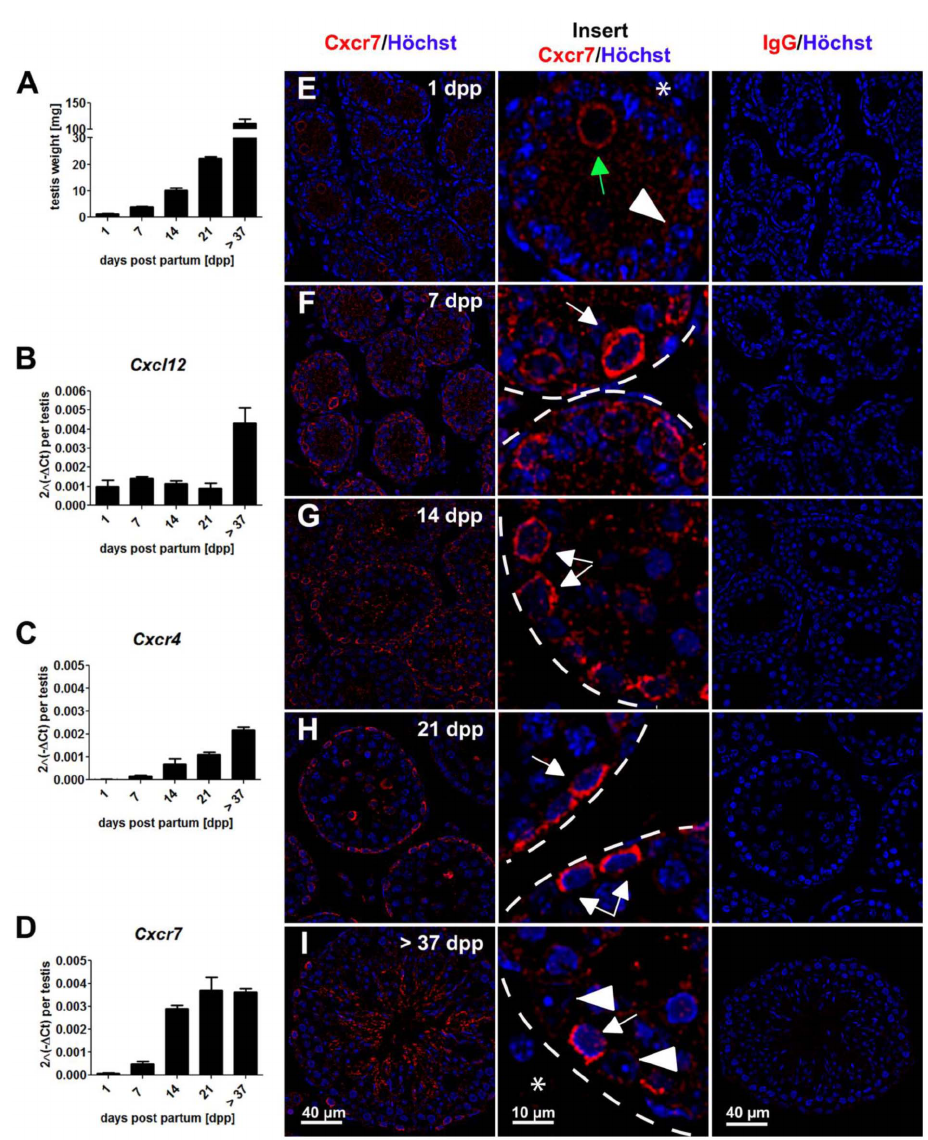
Figure 1. Expression pattern of Cxcr7 during testicular germ cell development. Changes in testicular weight (A) as well as changes in transcript levels of Cxcl12 (B), Cxcr4 (C) and Cxcr7 (D) during postnatal development in mouse testes ((1d pp and , 37d pp (n 5 3); 7d pp , 14 d pp , 21 d pp (n 5 4)), 2 ( 2 D Ct) per testis, relative to luciferase ). Results are shown as mean ¡ SD. Representative images showing immunofluorescence stainings for Cxcr7 (red) and Hoechst (blue) on days 1, 7, 14, 21, . 37 of postnatal testicular development (first column, E–I). Within the inserts (second column) expression of Cxcr7 was observed in gonocytes (green arrow), spermatogonia (white arrows) and interstitial cells (asterisks). Sertoli cells are indicated with white arrowheads. Results of the respective negative controls using nonspecific IgG antibodies are shown in the right column (IgG/ Hoechst). Scale bars represent 10 m m and 40 m m,